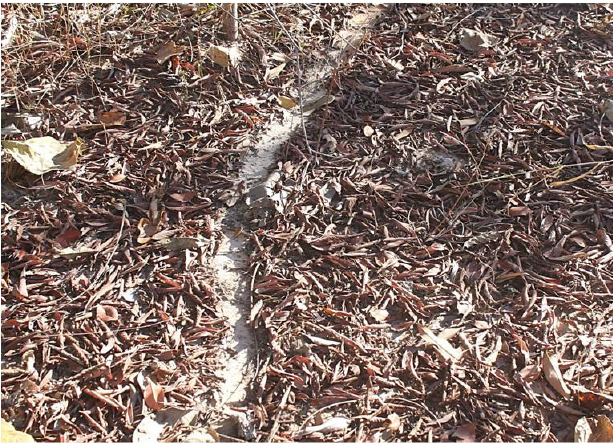
Fig 1 . Atta sexdens physical trail. Parque Estadual do Rio Preto - MG,